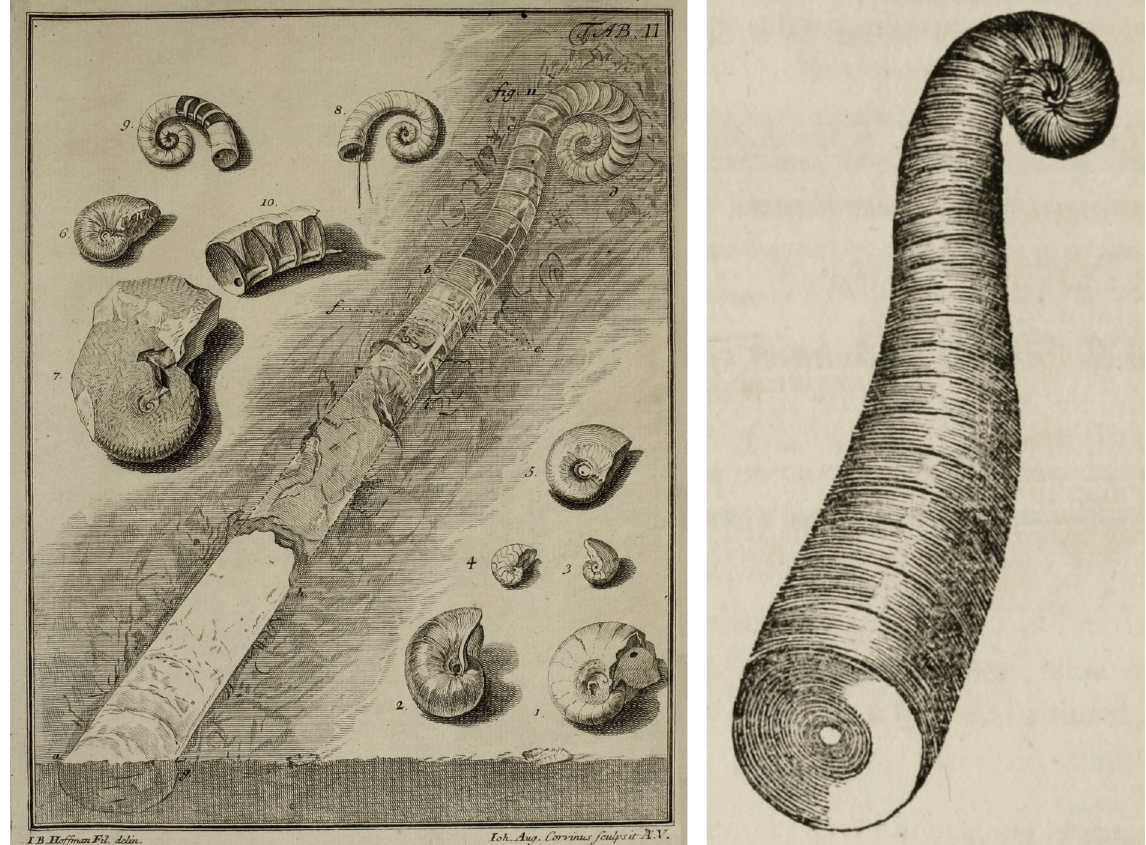
Fig. 2. Historical illustrations of Lituites specimens of Breyn (1732) (left) and de Montfort (1808)